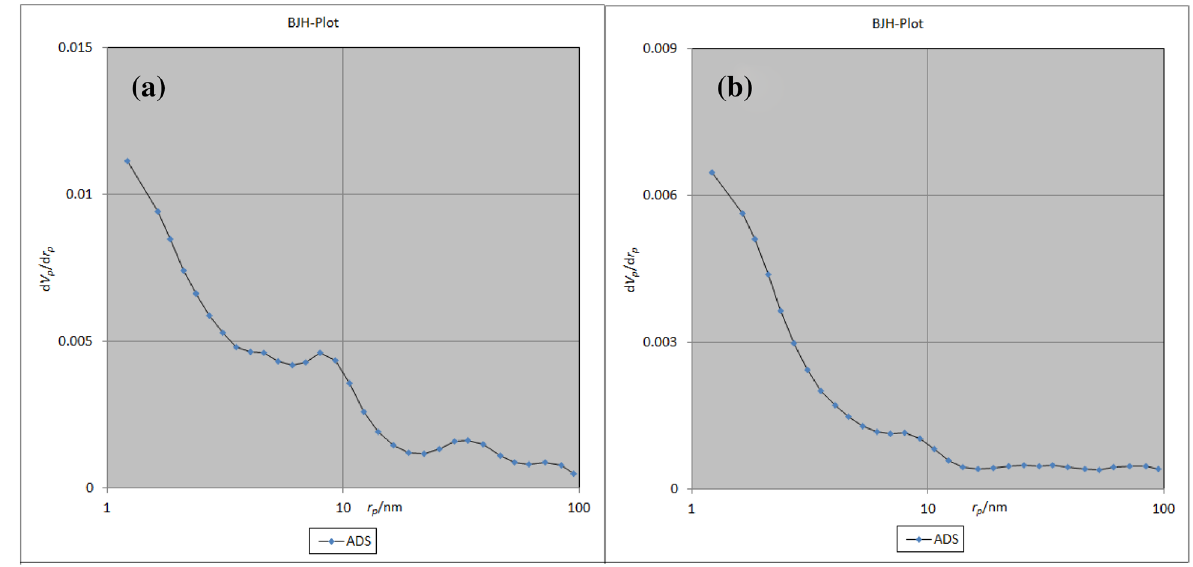
Figure 9. BJH-plot of ZIF-8/GO/MgFe 2 O 4 (a) , and ZIF-8/GO/MgFe 2 O 4 /TC (b) .